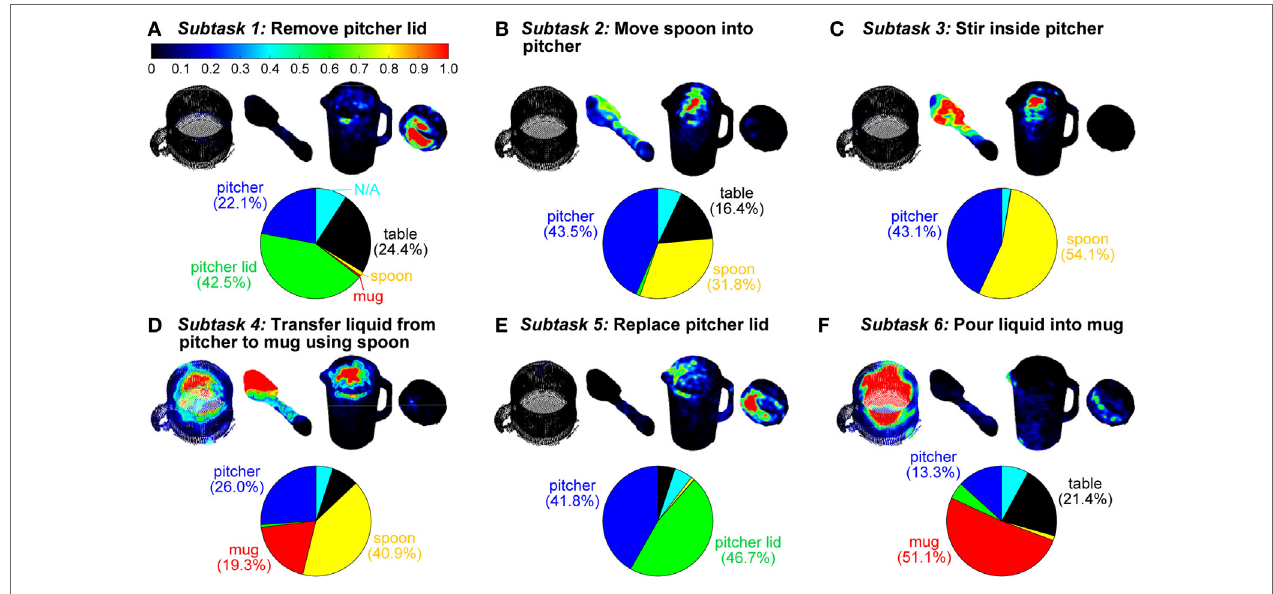
FigUre 5 | Three-dimensional gaze saliency maps of the task-related objects (mug, spoon, pitcher, and pitcher lid) are shown for each of the six subtasks (a–F) . The RGB color maps were summed across subjects and then normalized to the [0, 1] range for each subtask. The RGB color scale for all gaze saliency maps is shown in panel (a) . Gaze object percentages are reported via pie charts. The colors in the pie charts correspond to the color-coded objects in Figure 1c